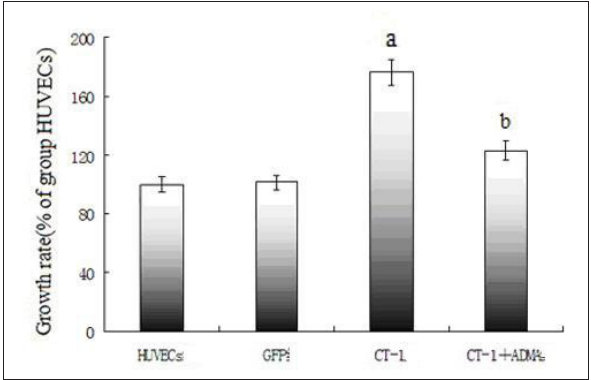
Fig. 3. Proliferation assay results at 48 h after transfection. a